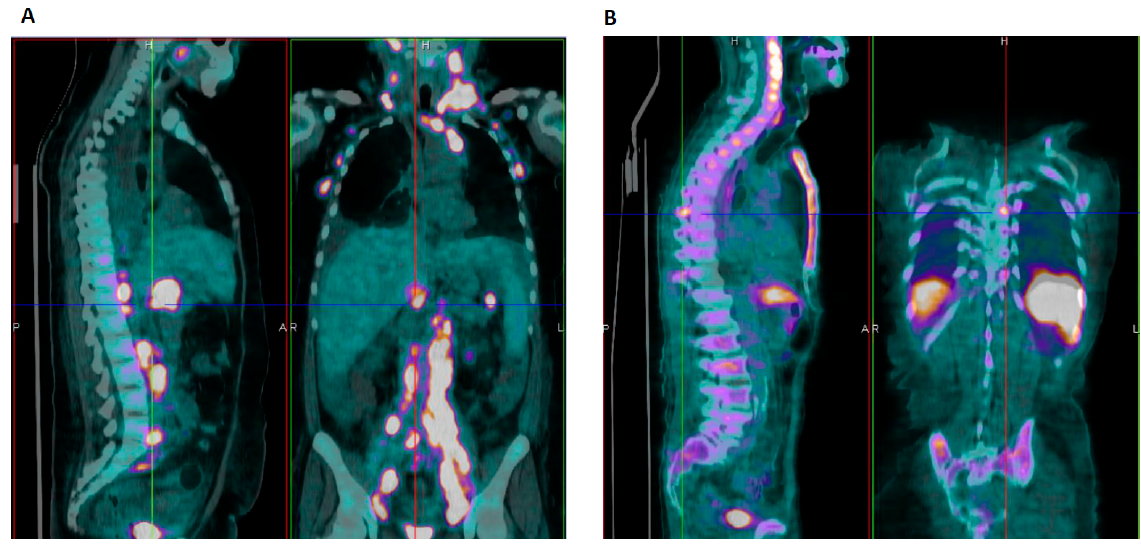
Figure 2. Positron emission tomography (PET) scan images of Patient #1 ( Panel A , markedly increased uptake in lymph-nodes and retroperitoneum) and Patient #2 ( Panel B , diffusely increased uptake in bone marrow and spleen).